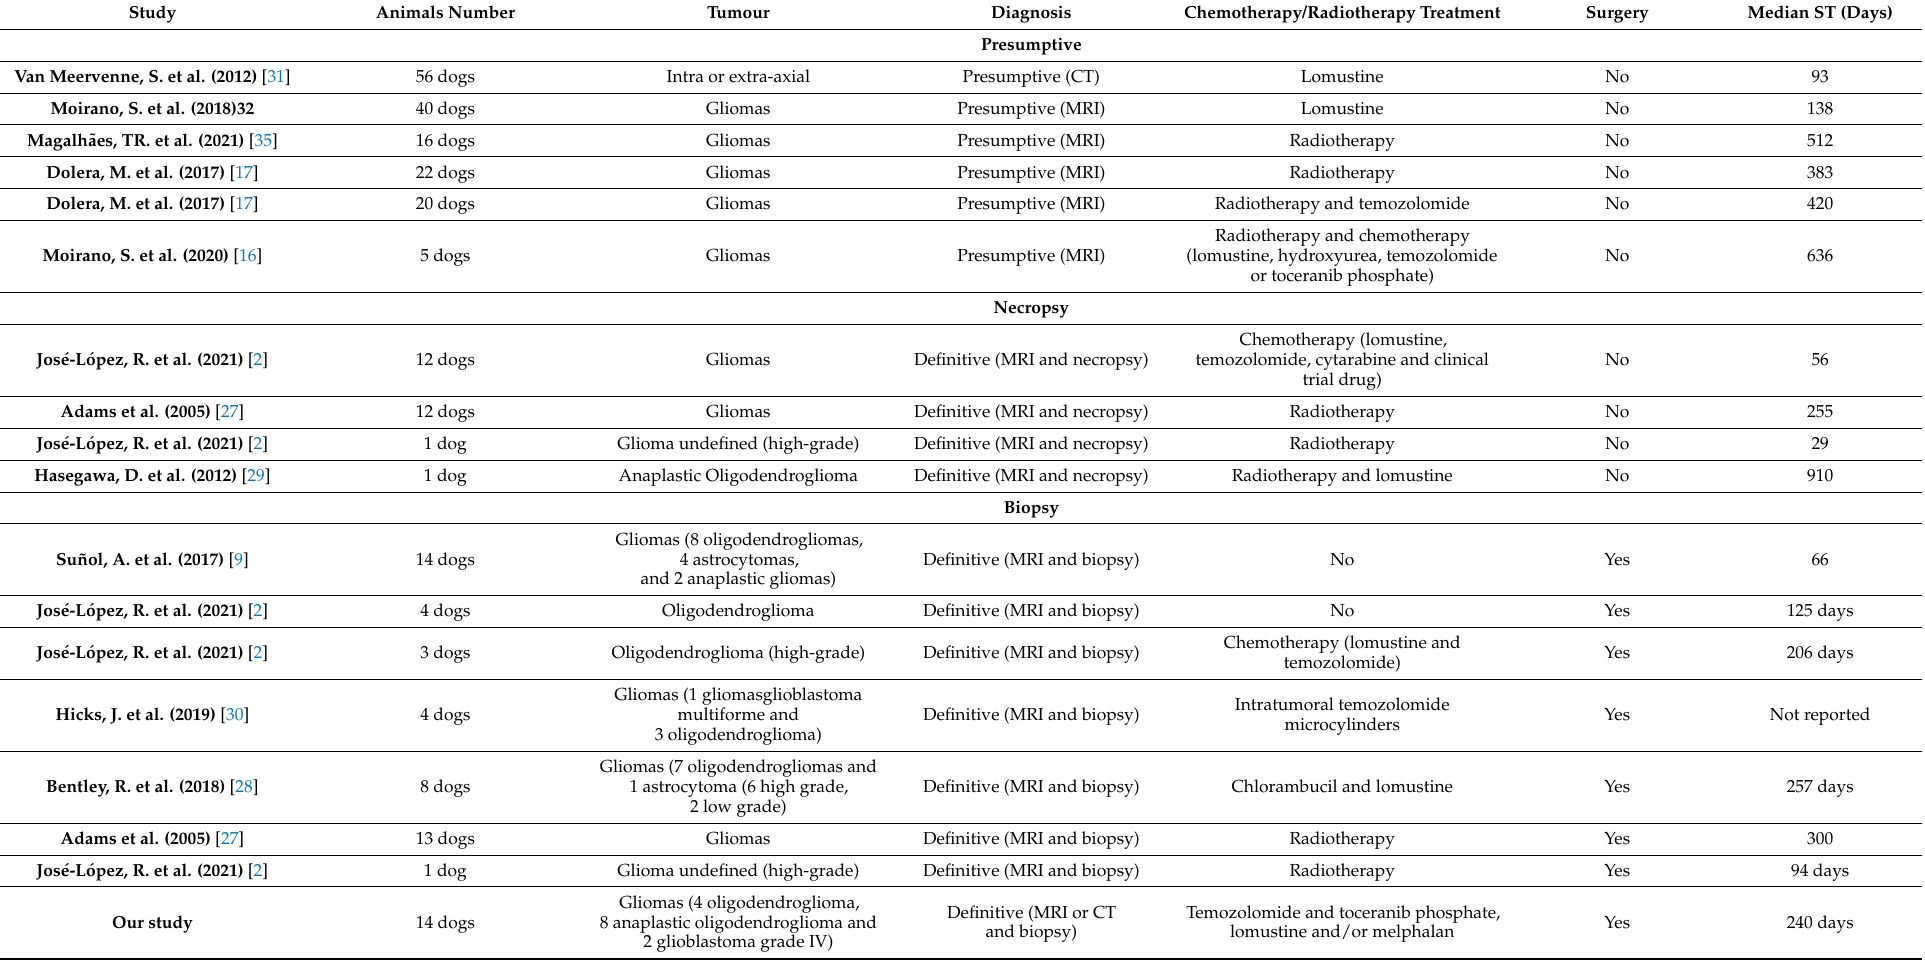
Table 2. Median survival times of canine glioma treatment studies to date with treatment modalities and comparison with the results of our